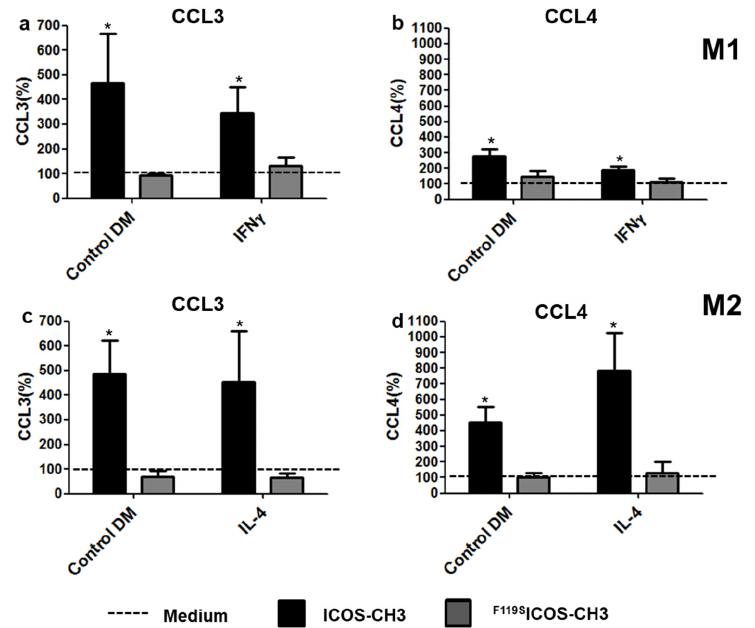
Figure 2. Chemokine secretion of M1 and M2 cells in the absence of LPS. M1 ( a , b ) or M2 ( c , d ) MDMs were cultured in differentiation media (DM) in the presence or absence of IFN γ IL-4 plus ICOS-CH3 or F119S ICOS-CH3. Culture supernatants were harvested after 2 d and examined for CCL3 and CCL4 production by ELISA. Data represent the mean and SEM expressed as a percentage of results from six independent experiments. The corresponding samples cultured in the absence of ICOS-CH3 or F119S ICOS-CH3 were set at 100% (whose absolute data are shown in Figure S2). * p < 0.05 vs. the corresponding 100% control. In M1 cells treated with LPS alone, ICOS-CH3 reduced the secretion of IL-10, IL-6, TNF- α , and CCL4 while it increased that of IL-23. When IFN γ was added to these mixtures, we could no longer observe any effect of ICOS-CH3 on IL-10, IL-6, and IL-23 secretion, while the inhibitory effect on TNF- α and CCL4 secretion was retained. In addition, it appeared to have an inhibitory effect on CCL3 secretion. Treatment with F119S ICOS-CH3 had no effect under any experimental conditions (Figure 3).